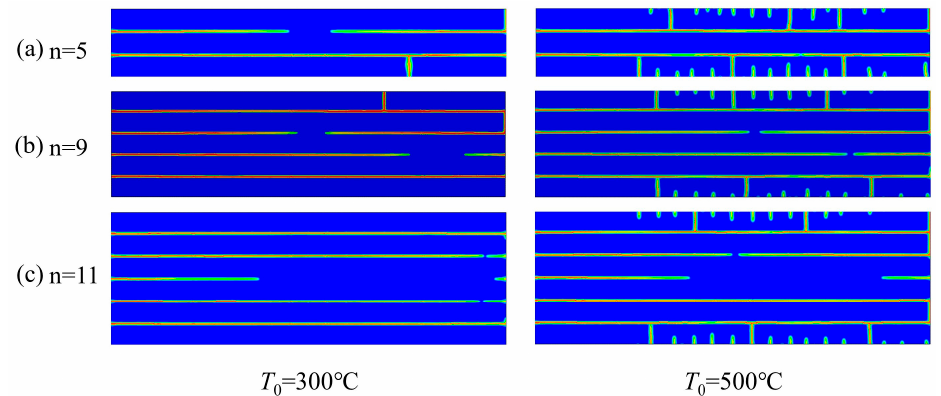
Figure 13. Numerical simulation results of thermal shock at different initial temperatures for layered ceramics with different layer thickness ratios, R = 5.